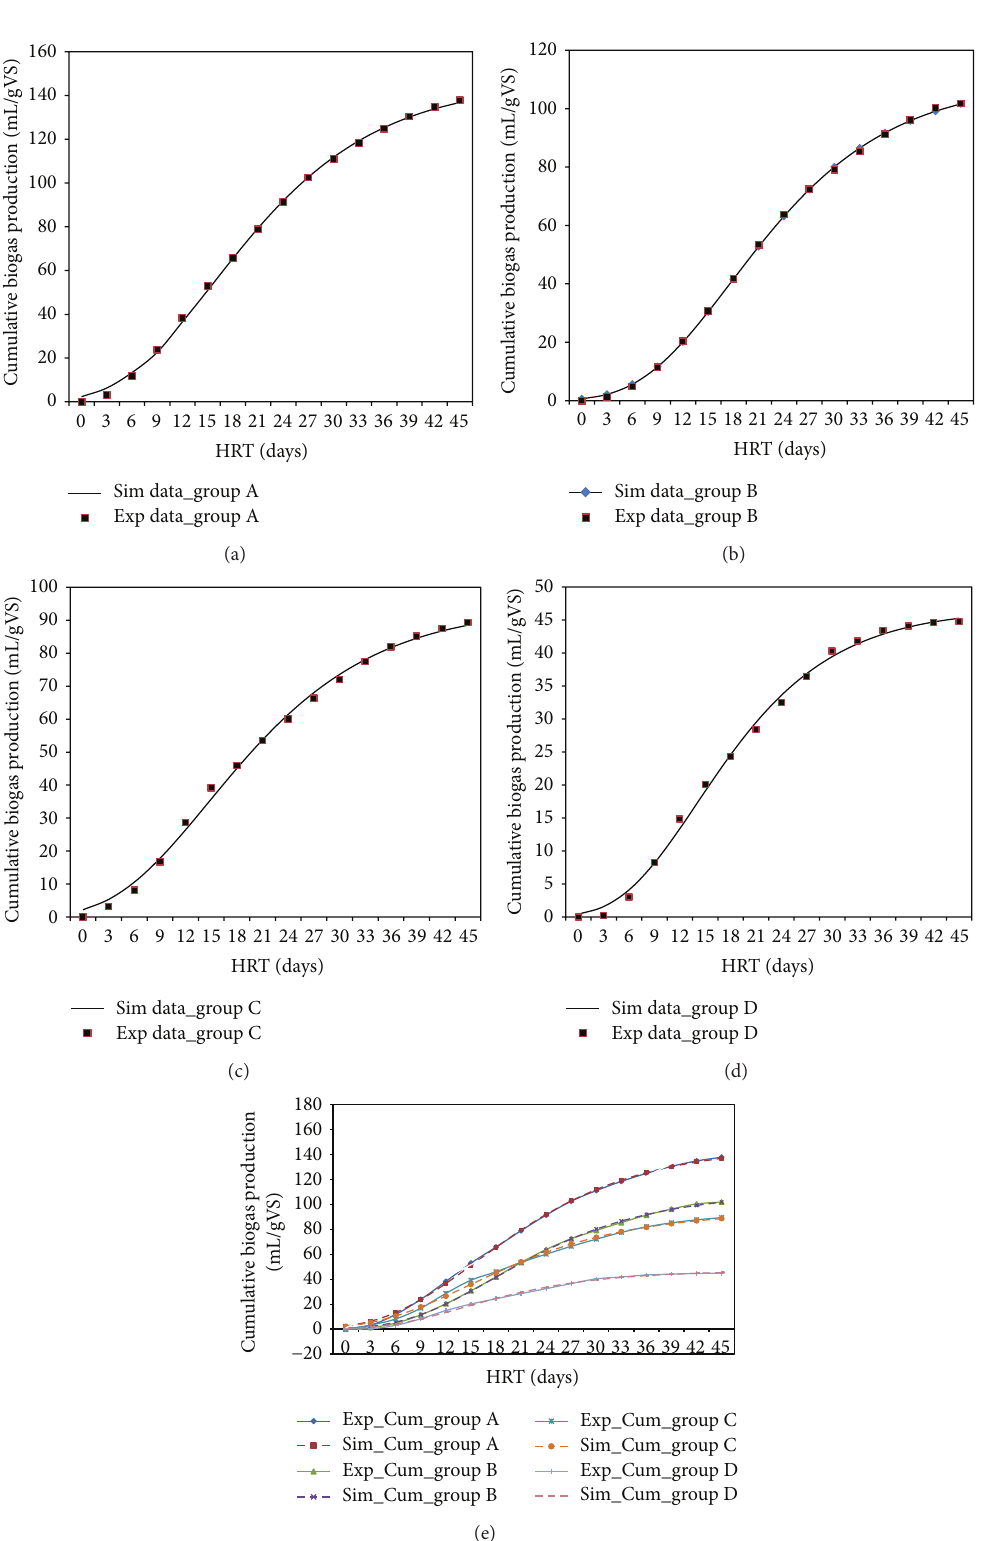
Figure 10: (a) Gompertz relation plot of cumulative biogas production for treated biomass at 135 ∘ C (group A). (b) Gompertz relation plot of cumulative biogas production for treated biomass at 85 ∘ C (group B). (c) Gompertz relation plot of cumulative biogas production for untreated biomass (group C). (d) Gompertz relation plot of cumulative biogas production for inoculum (group D). (e) Comparative plot for experimental and Gompertz relation simulated cumulative biogas